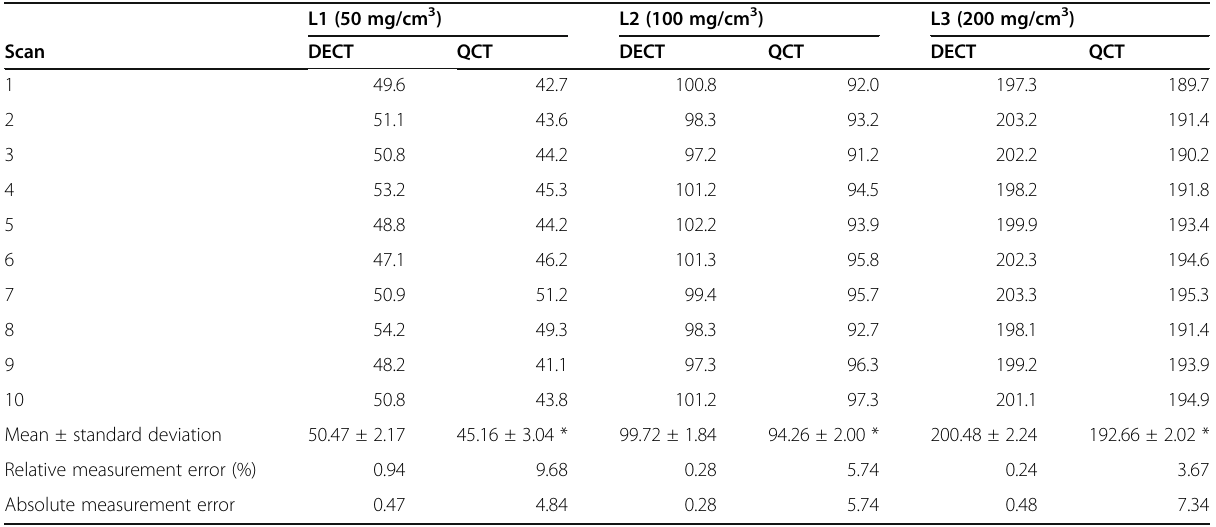
Table 1 Values of bone mineral density using dual-source DECT and QCT L1 (50 mg/cm 3 )